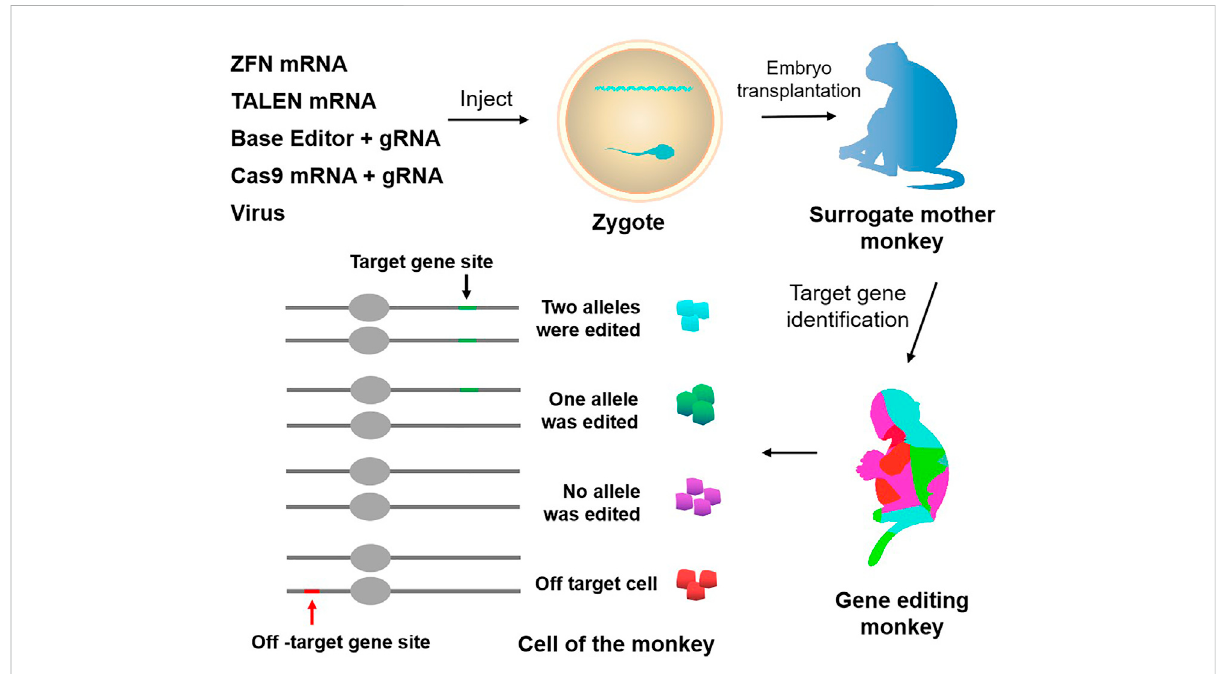
FIGURE 1 Approaches to genetically modify monkeys. Current techniques to genetically modify monkeys include virus, ZFN, TALEN, CRISPR-Cas9, and base editor. Chimerism exists in gene editing monkeys, and there is the potential for off-targeting.